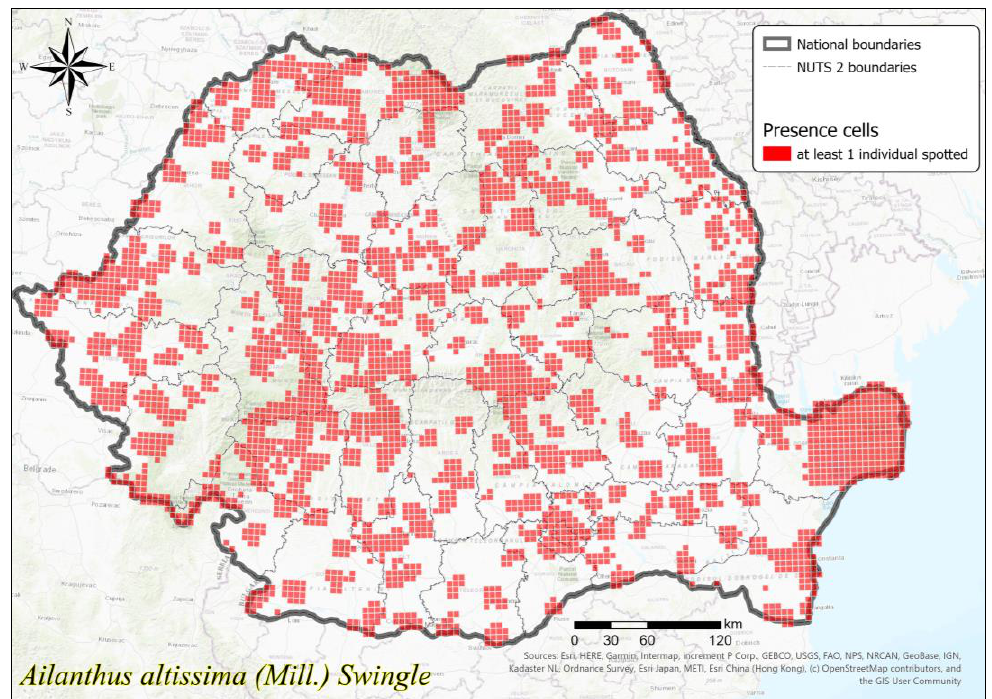
Fig. 1. Ailanthus altissima is the most widespread invasive alien plant in